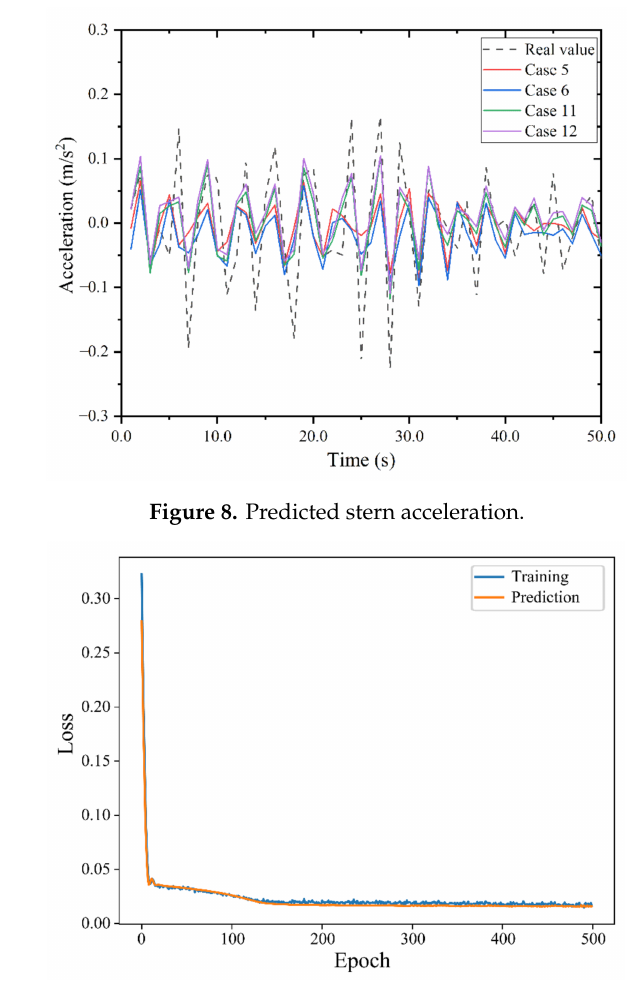
Figure 9. Loss comparison (Case